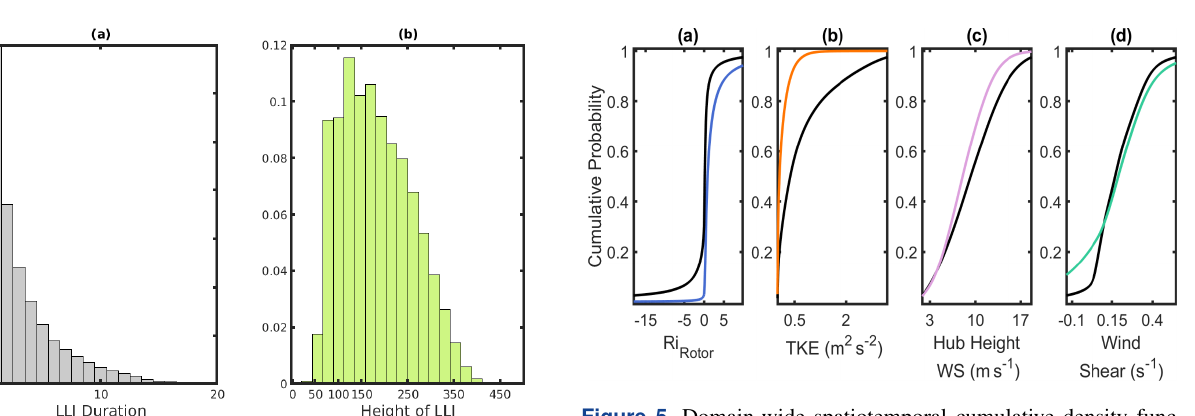
Figure 5. Domain-wide spatiotemporal cumulative density func- tions for conditions during hours with LLJ (colored) and without (non-LLJ) (black). Quantities (shear, TKE and Ri Rotor ) are cal- culated at each of the six vertical layers within the nominal rotor plane (50 to 150ma.g.l.), then averaged to obtain central tenden- cies (mean, median): (a) median Ri Rotor , (b) mean TKE across the rotor plane, (c) hub height wind speed (wind speed at 100ma.g.l.), (d) mean wind shear across the nominal rotor plane. For enhanced visibility, each subfigure is cropped at the 2.5th and 97.5th per- centile values of non-LLJ